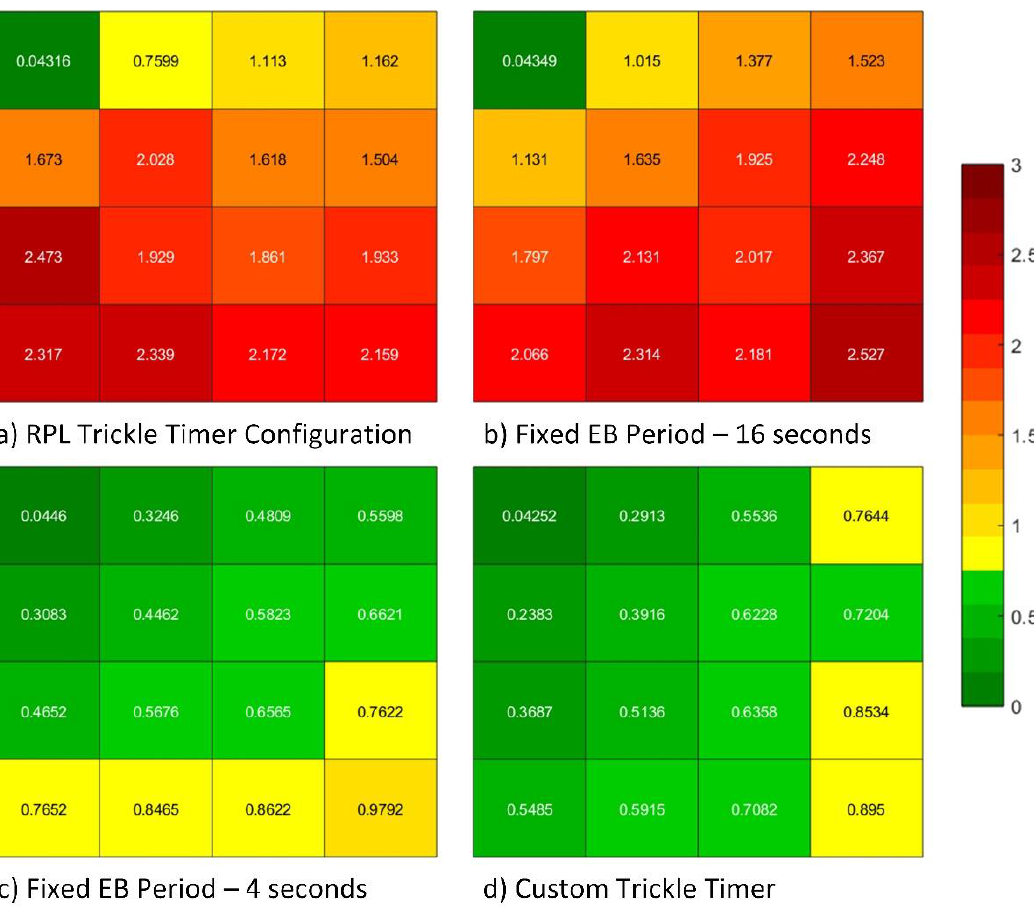
Figure 13. The power consumption for different EB period Figure 13 . The power consumption for different EB period configurations.